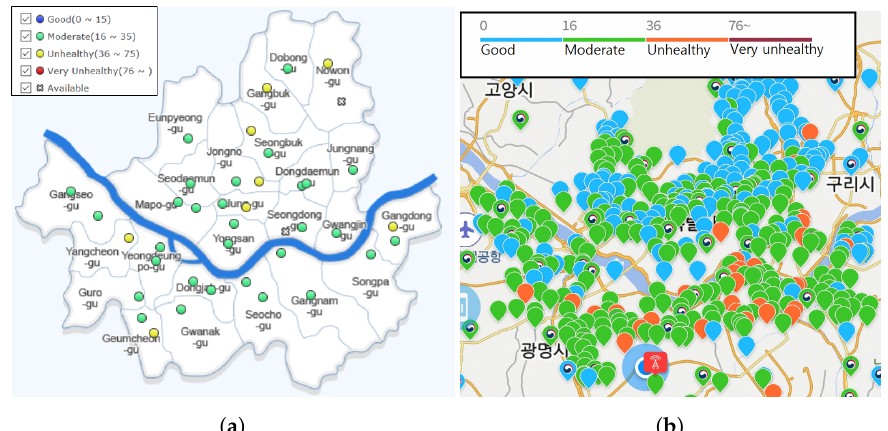
Figure 1. Comparison of deployment density by the responsible organization in Seoul. A circle indicates the location of equipment with Korea air quality index (AQI) of PM2.5. ( a ) By government (BAM); ( b ) By a company (Light-scattering)